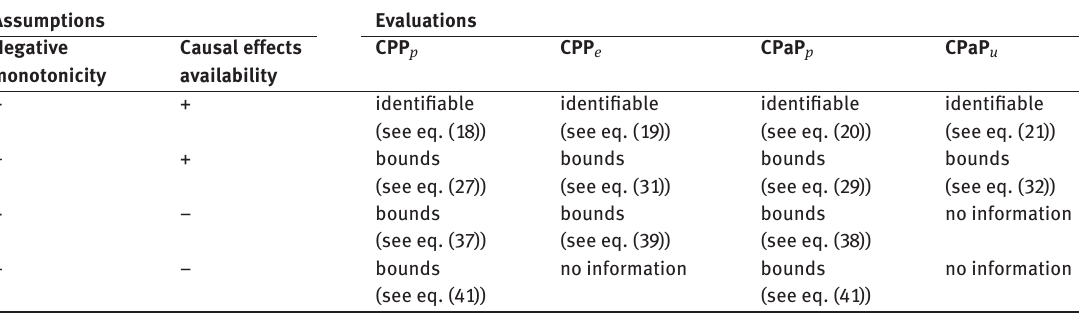
Table 1: Summary of assumptions and evaluations of CPPs and